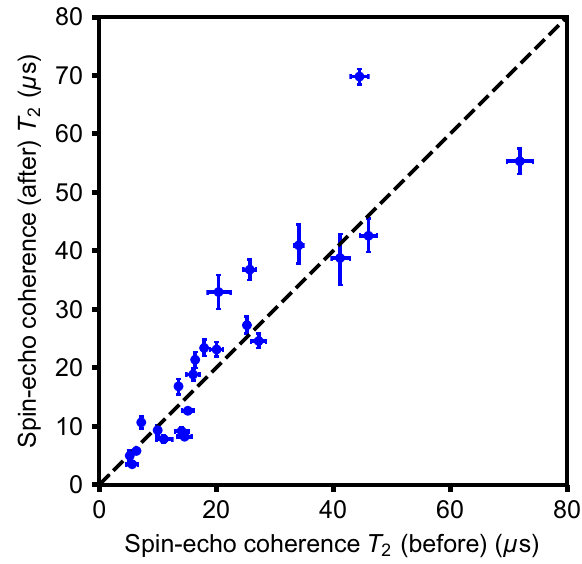
FIG. 6. Coherence times of NV centers in Sample 8 after annealing, plotted as a function of preannealing coherence times. Dashed line has a slope of